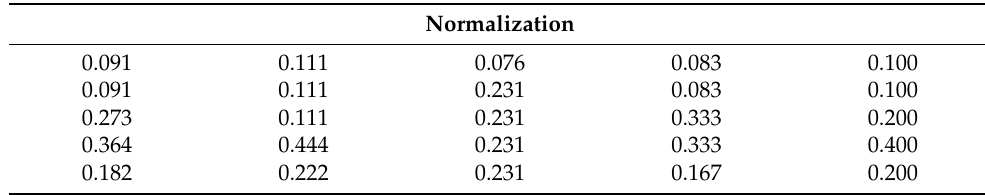
Table 7. AHP normalization